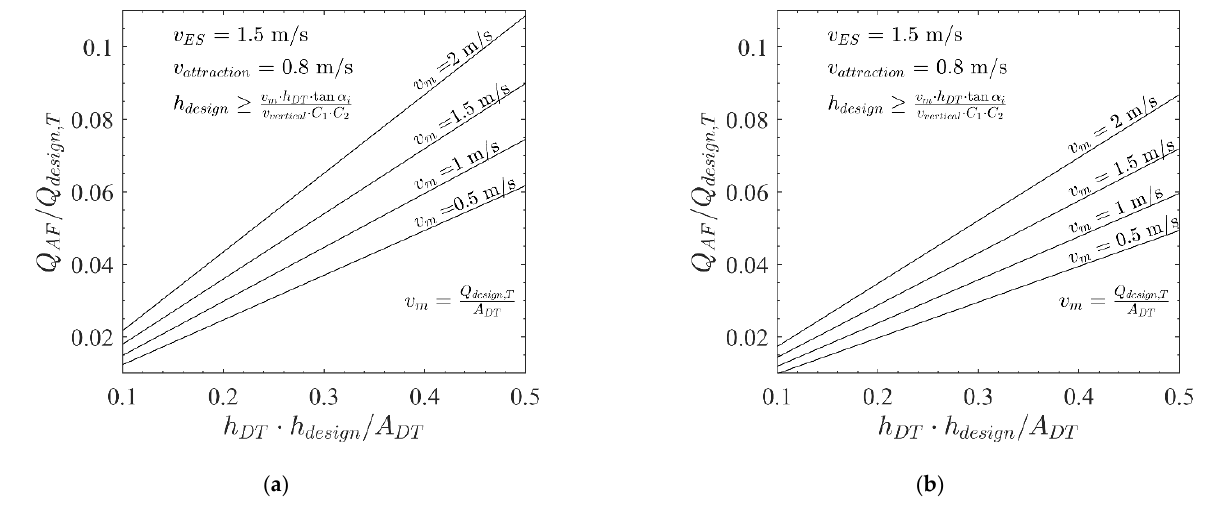
Figure 8. Attraction discharge Q AF normalized by design discharge of the adjacent turbine Q design , T at hydropower plant for a velocity at entrance slot v ES = 1.5 m/s and a form factor k = 1 determined using Equations (10)–(14) for hydraulic conditions at Q design ( a ) for vertically mounted Kaplan turbines and ( b ) for horizontally mounted Kaplan turbines; v attraction = minimum attraction velocity; h design = downstream water depth at the entrance slot; h DT = water depth at draft tube exit section; A DT = area of the draft tube exit section. Table 2. Summary of basic parameters of the case study dams used to determine attraction flow. Parameters